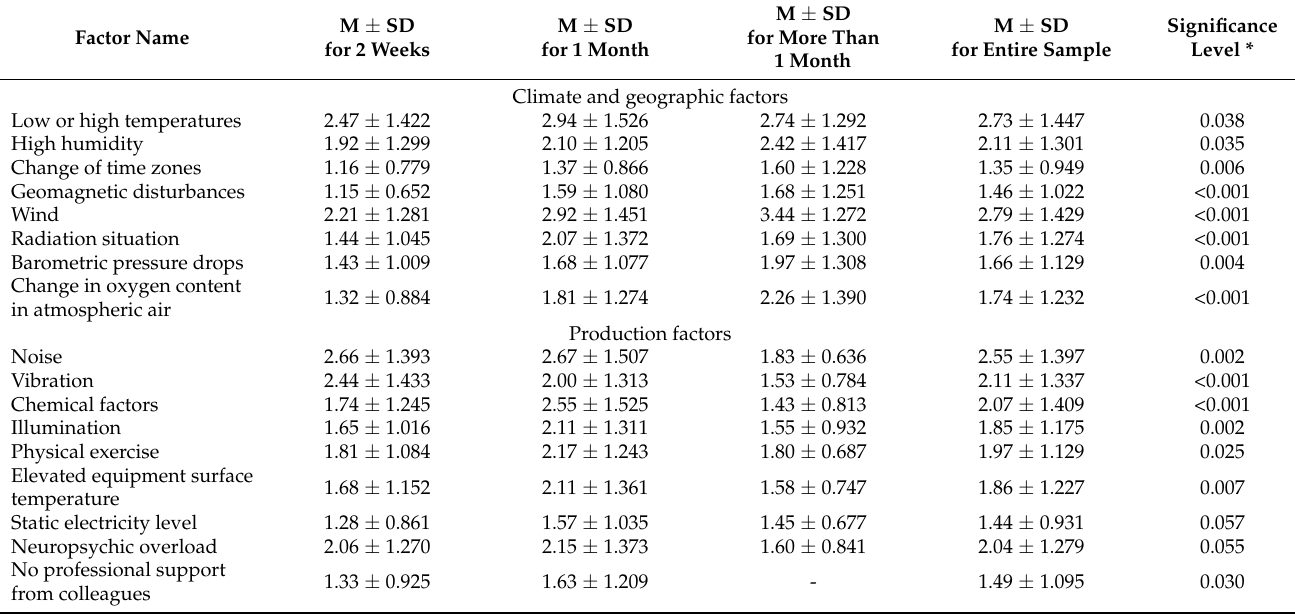
Table 4. Statistically significant differences according to univariate tests in the subjective assessment of the discomfort of climate and geographic, production and social factors in FIFO personnel with a different fly-in period duration (on a five-point scale, where 5 is the most uncomfortable factor, 1 is the least uncomfortable